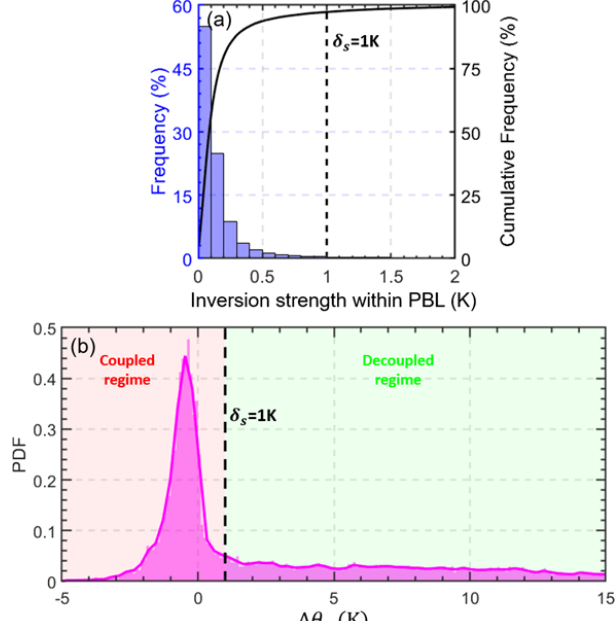
Figure 3. (a) Blue bars represent the inversion strength of θ v within the PBL. The inversion strength is derived from the radiosonde during daytime (08:00–19:00LT). The inversions near the surface or across PBL top are excluded. The solid black line represents the cumulative frequency. (b) Pink area represents the probabil- ity density function (PDF) of the differences in the virtual po- tential temperature between cloud-base height (CBH) and PBLH ( (cid:49)θ v = θ CBH v − θ PBLH v ). By using a threshold of (cid:49)θ v < δ s (1K), we can identify the coupled cloud